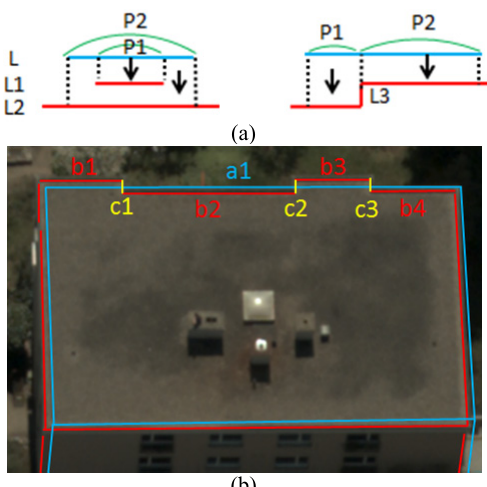
Fig.7. (a) Two operations to transform boundary lines. (b) an example of boundary line decomposition